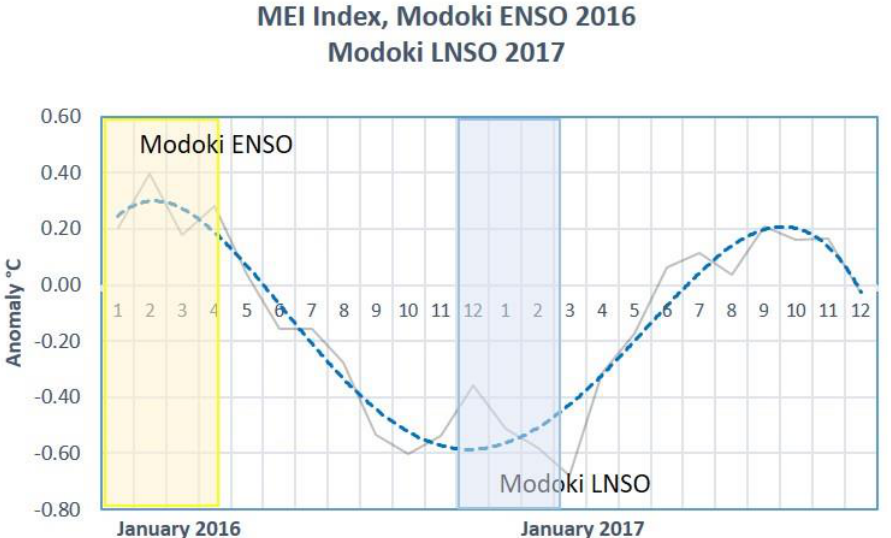
Figure 3. Time series of the MEI index, showing the presence of 2016 ’ s Modoki ENSO and 2017 ’ s Modoki LNSO.